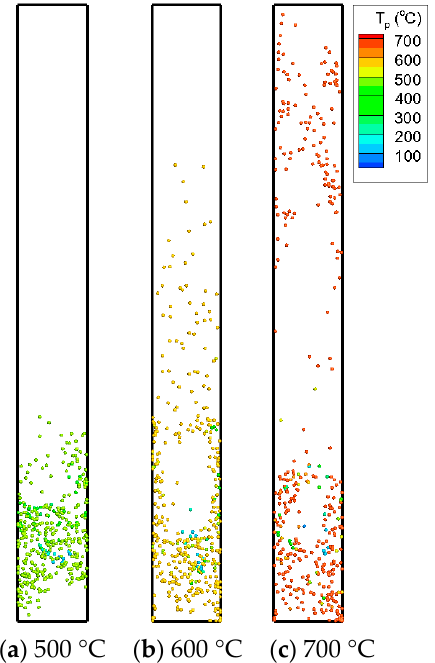
Energies 2020 , 13 , x FOR PEER REVIEW Figure 10. Biomass particle distribution at t = 10 s under different pyrolysis temperatures. Figure 10. Biomass particle distribution at t = 10 s under di ff erent pyrolysis temperatures.